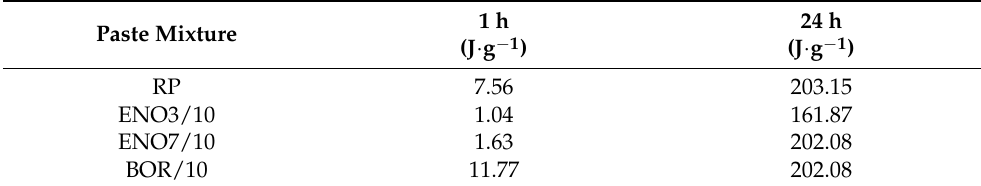
Table 9. Hydration heat of tested pastes relative to cement